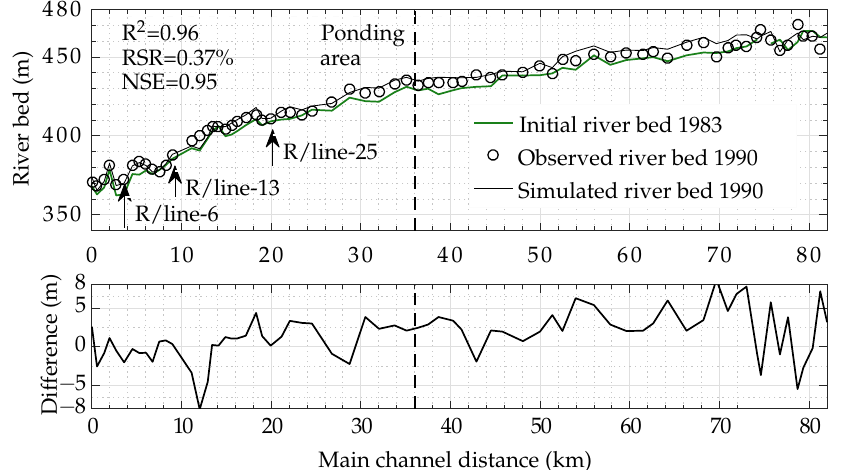
Figure 14. Longitudinal profile of mean measured and computed river bed at the end of the validation process.